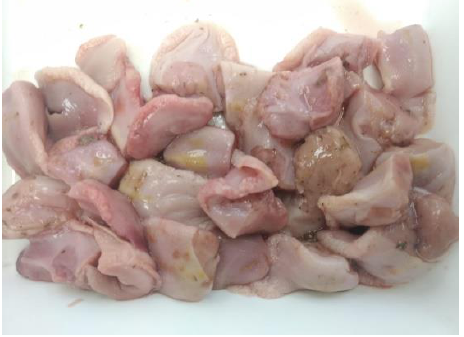
Figure 1. A representative sample of thawed tongue tips following the collection procedure.